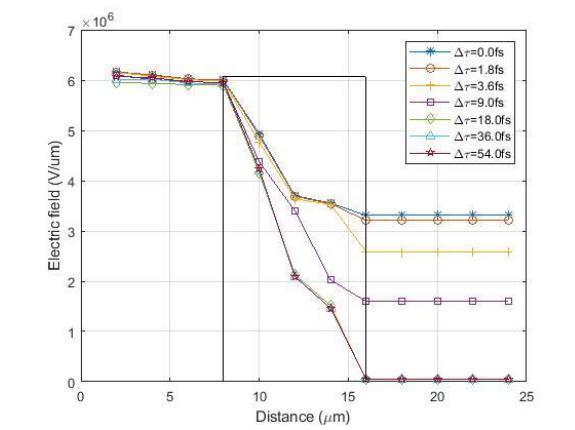
Fig. 1. Electric field during the propagation of two pulses through a SA at different delay times between pulses. SA is shown as a solid square in the